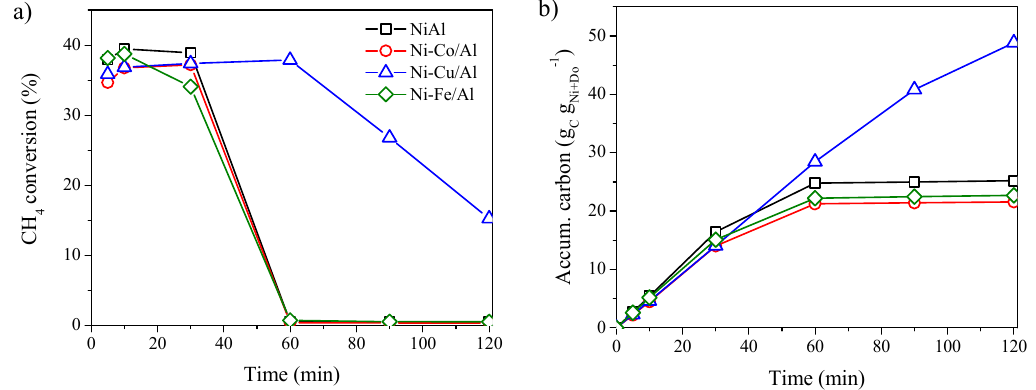
Figure 5. ( a ) Methane conversion; and ( b ) accumulated carbon. CDM carried out in a quartz FBR for 120 min with an operating temperature of 650 °C.